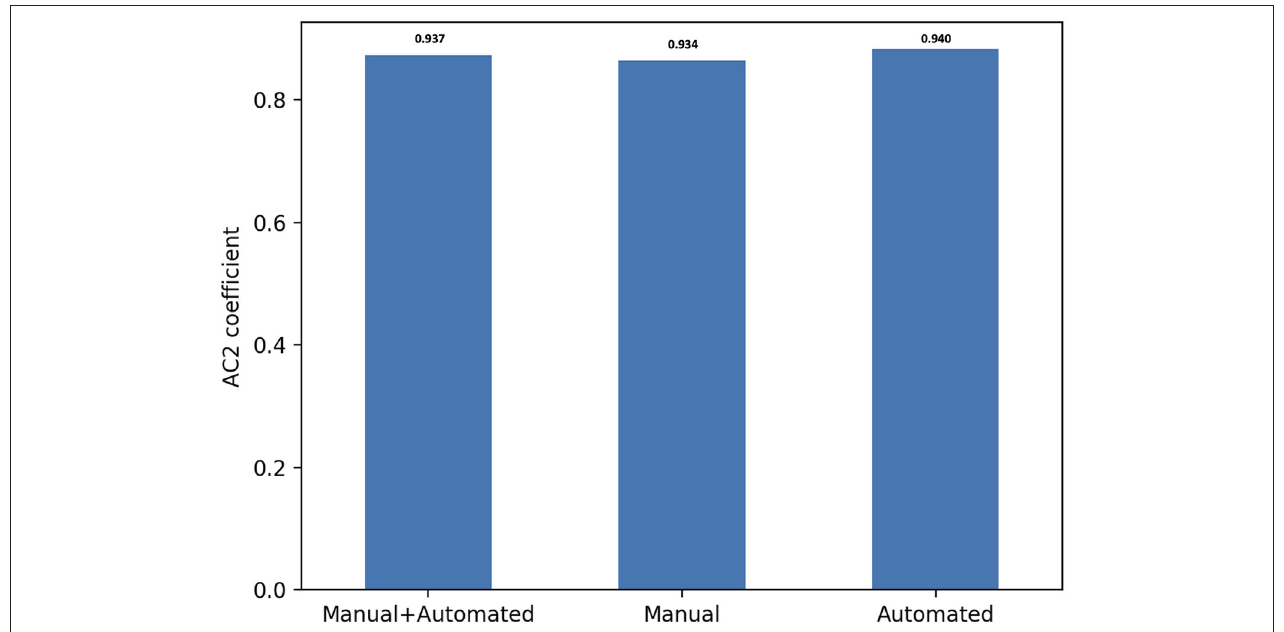
FIGURE 4 | Score agreement between all raters for manual, automated contours and both segmentation methods. The interobserver reliability is expressed using Gwet’s second-order agreement coefficient with ordinal weighting applied (AC2) (y